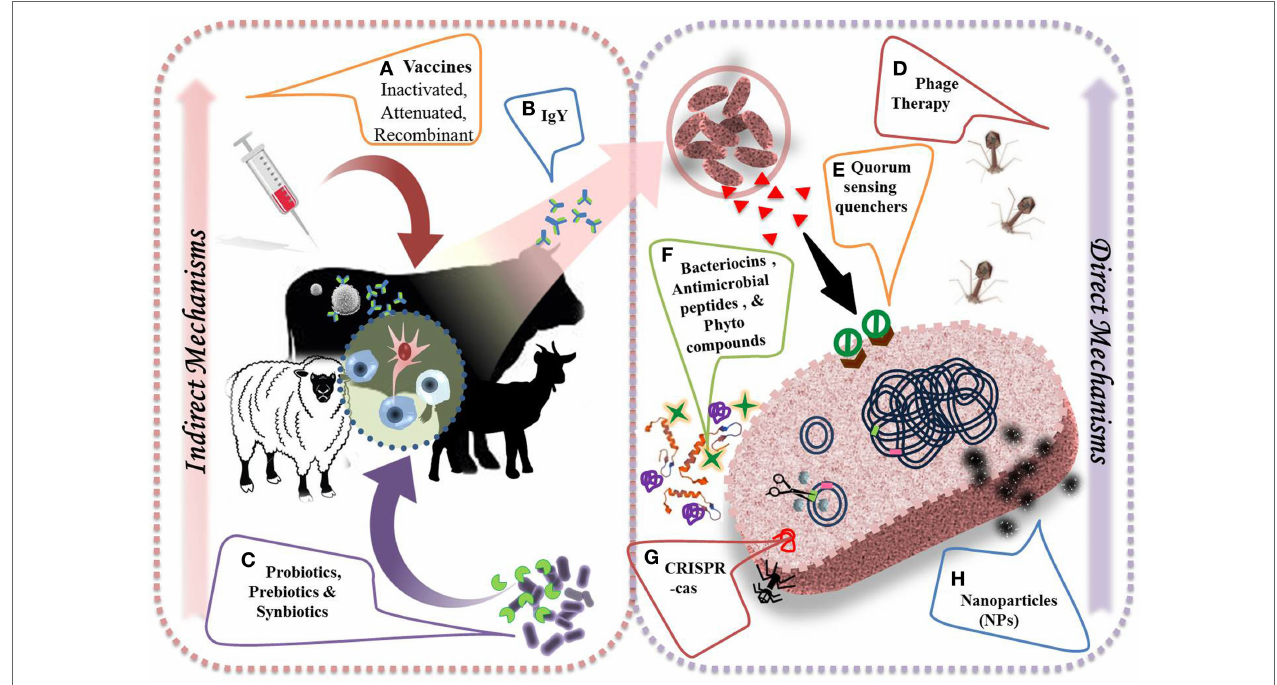
FiGURe 4 | Alternative strategies to combat antimicrobial resistance and their direct and indirect mechanisms of action. (A) Vaccination helps in preventing the course of infections by evolving immune cells (i.e. B cells , T cells ) to develop an adaptive immunity by producing specific antibodies ( ) against important pathogens. (B) Chicken egg yolk antibodies provide effective treatment approach against several viral and bacterial diseases. (C) Probiotics ( ), prebiotics ( ), and synbiotics improve general health by selectively stimulating innate immune cells ( ). (D) Lytic bacteriophage or their purified gene products could be used to treat sepsis and few bacterial infections. (e) Quorum sensing quenchers ( ) could control virulence of pathogens by inhibiting the binding of auto-inducers ( ) to respective receptors. (F) Antimicrobial peptides ( ), bacteriocins ( ), and phytocompounds ( ) directly inhibit the bacterial growth by acting on bacterial cell membrane. (G) Modified CRISPR-Cas approach targets resistance genes in pathogens and reverse the selective pressure of resistance. (H) Metal-based nanoparticles